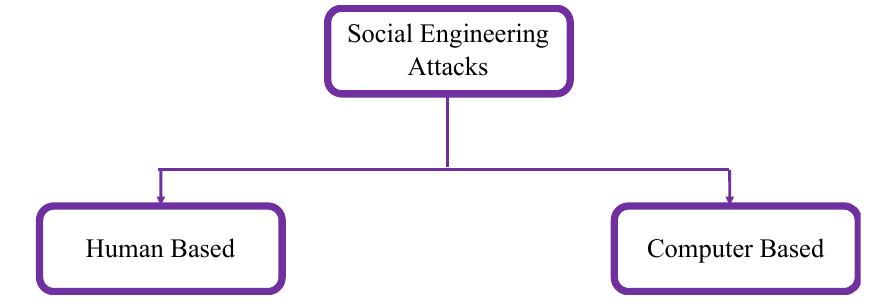
Figure 2. Social engineering attacks classification.